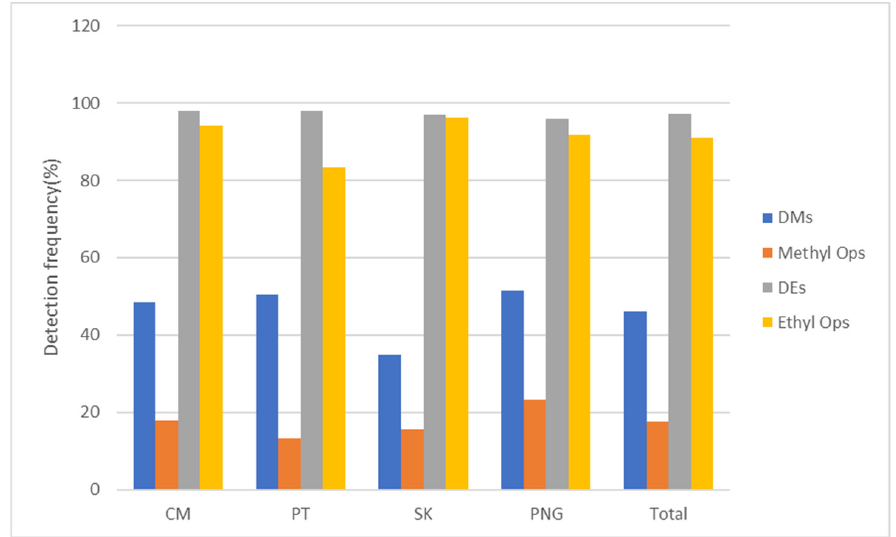
Figure 2. Detection frequency of OP residues and DAP metabolites by province.